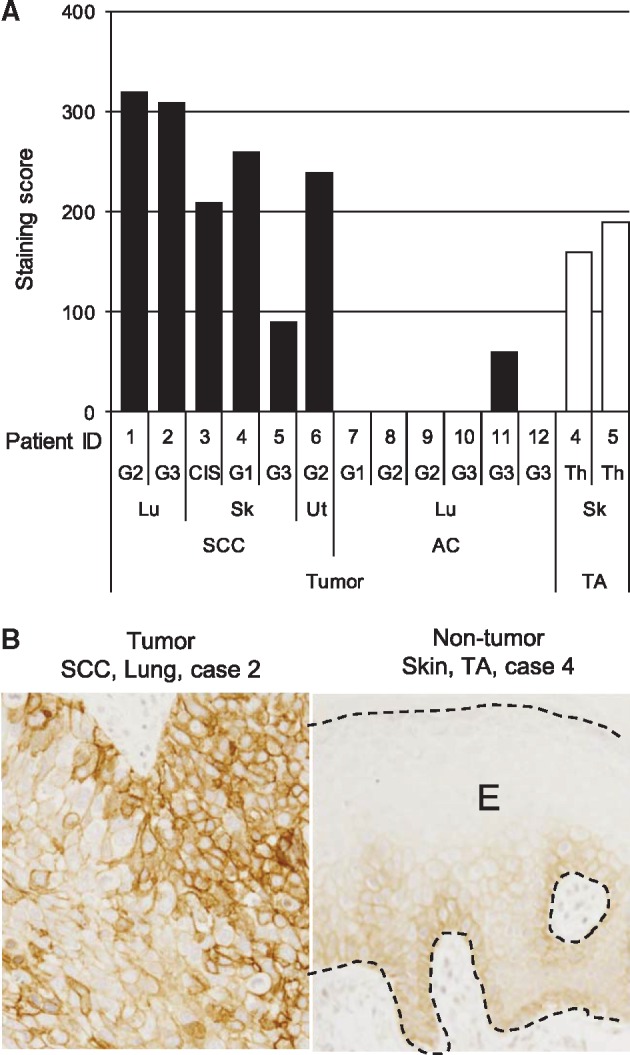

Expression of DSG3 in human tissues. (A) DSG3 was expressed frequently in SCC of various organs compared with adenocarcinoma of the lung. Tumour-adjacent skin also expressed DSG3. G1–G3, histology grade; CIS, carcinoma in situ; Th, thickening of epidermis; SCC, squamous cell carcinoma; AC, adenocarcinoma; TA, tumour-adjacent tissue; Lu, lung; Sk, skin; Ut, uterus. (B) Images of IHC staining in SCC of the lung (left panel) and tumour-adjacent skin (right panel). Labelled streptavidin-biotin method. E presents epidermis. Bar = 100 µm.